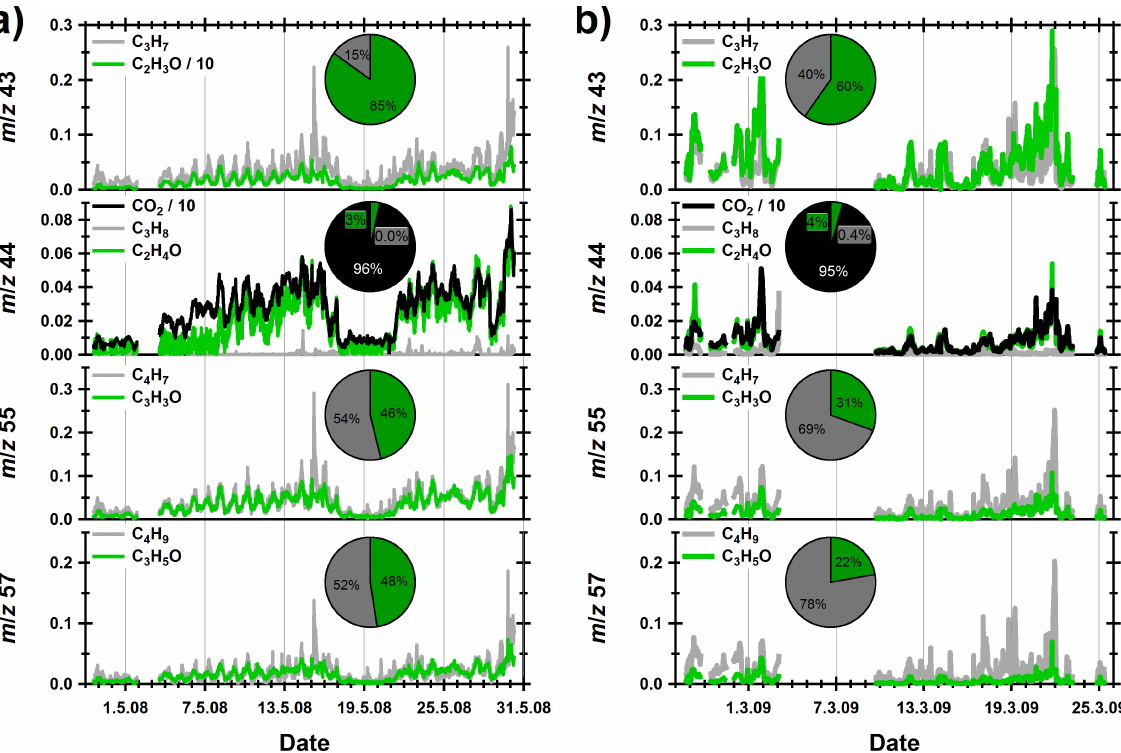
Fig. 10. Time traces of different organic ions at mass to charge ratio m/z 43, m/z 44, m/z 55, and m/z 57 from top to bottom in May 2008 (a) and March 2009 (b) , respectively. Please note, in 2008 the signals of C 2 H 3 O + on m/z 43 and CO + allow for parallel display on the same axis as the other ions at the respective m/z . In 2009 this is only the case for CO +